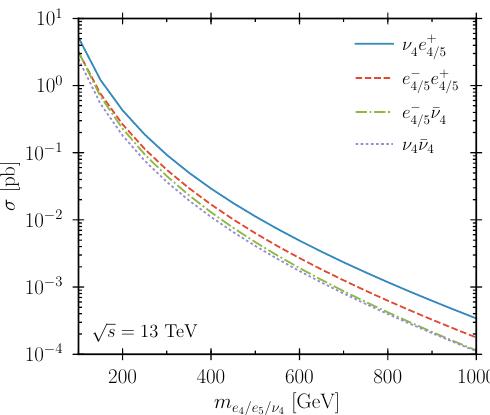
Figure 11 . Production cross sections for heavy lepton pairs at the LHC with a center-of-mass energy of 13 TeV, assuming equal masses for all heavy leptons.